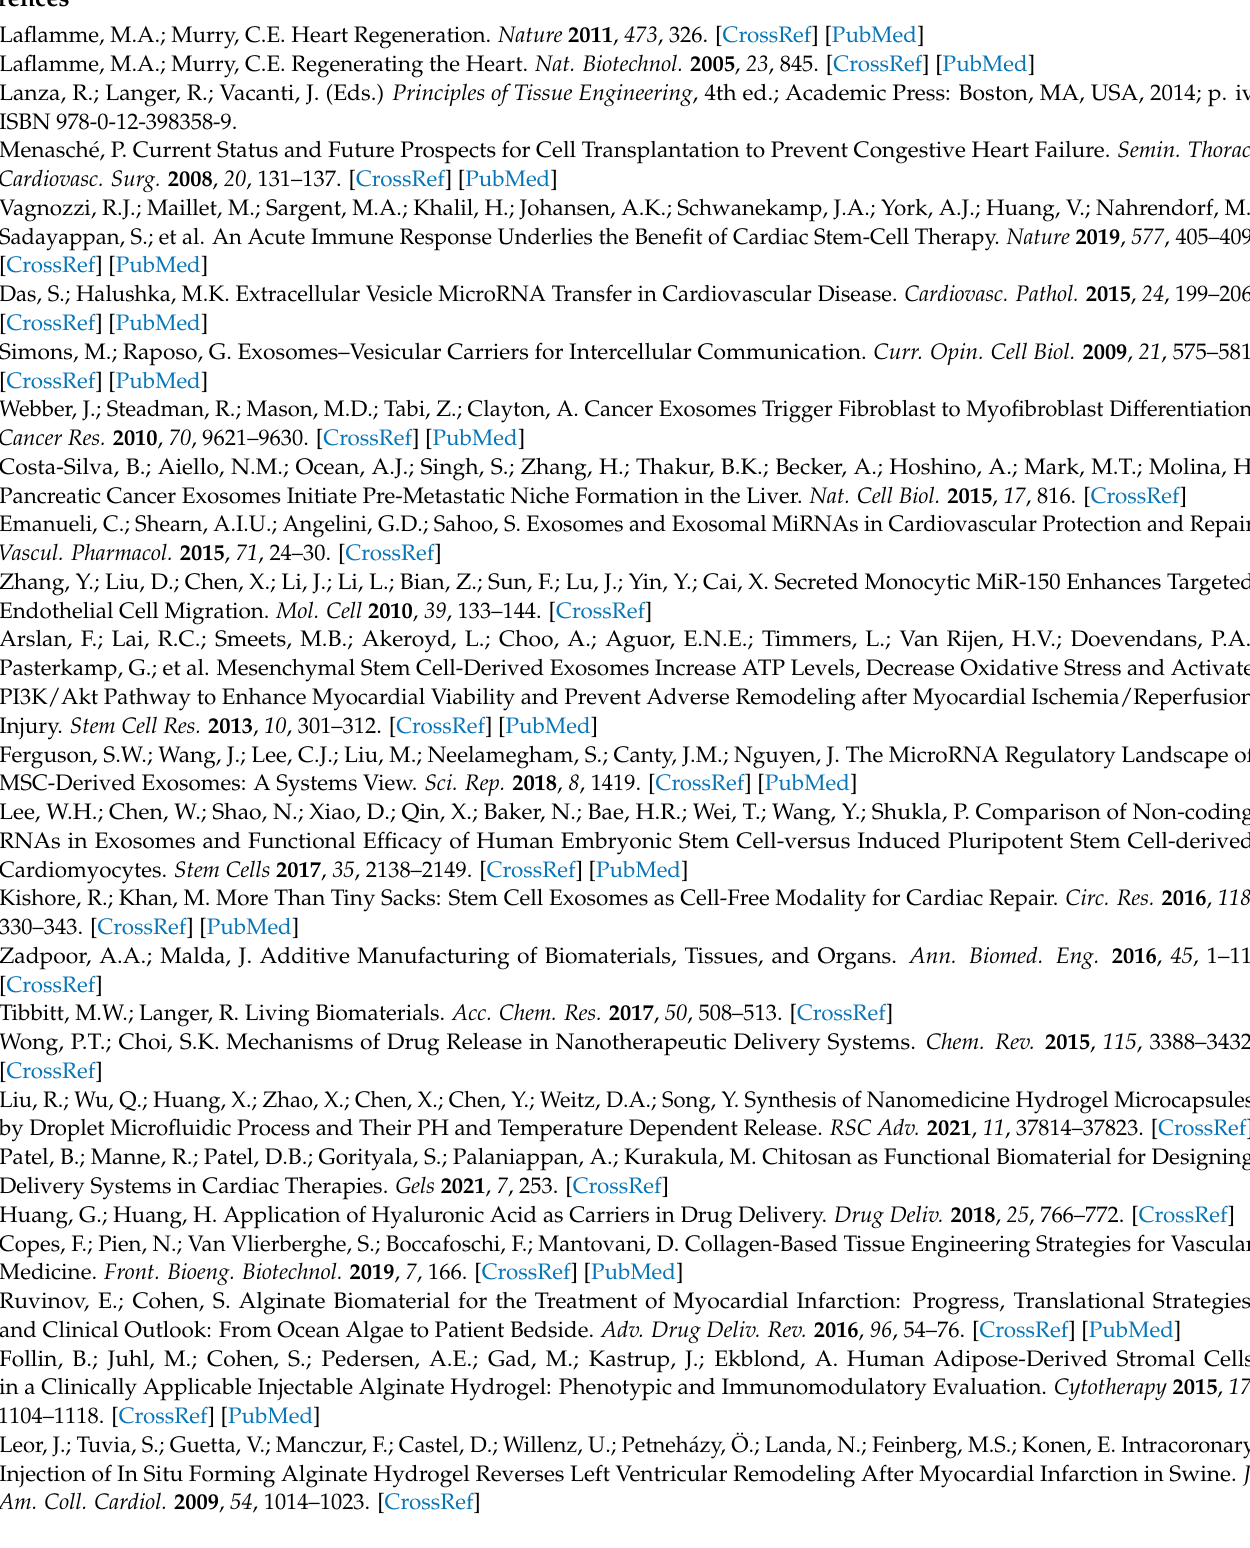
0.3% Ca 2+ , 3% Gelatin (right), 6 days post printing. Scale bar: 200 µ m. Green: F-Actin, red: Fluo- rescently labeled alginate. ( B ) Quantification of the cells aspect ratio measurements inside the 3D constructs over time. Data represented in